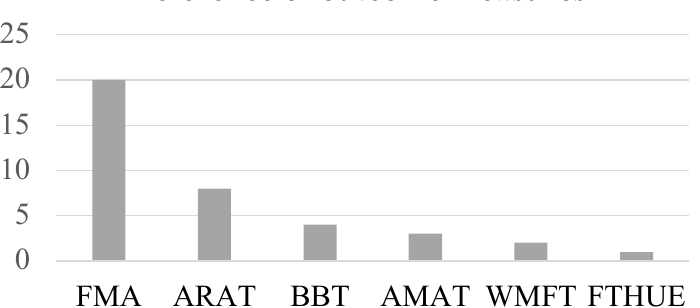
Figure 5. The preference of outcome measures used is shown. FMA: Fugl-Meyer motor assessment scale for upper extremity; ARAT: action research arm test; BBT: box and block test; AMAT: arm motor ability test; WMFT: Wolf motor function test; FTHUE: functional test for hemiparetic upper extremity.